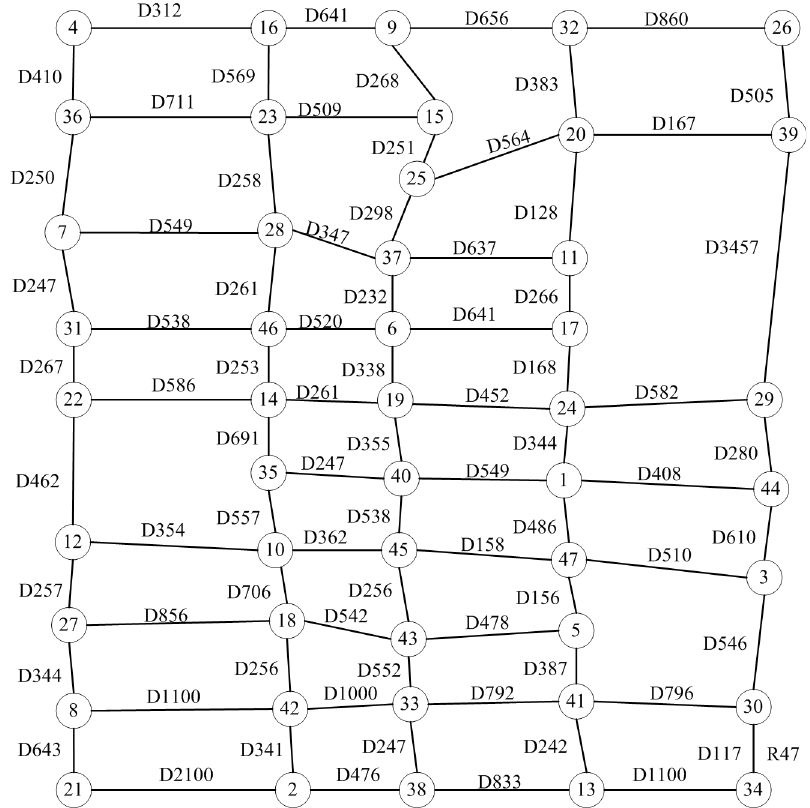
Fig 6. Part of the transport network of Xifeng District in Qingyang, China. Note: Dxxx is the distance of the road.